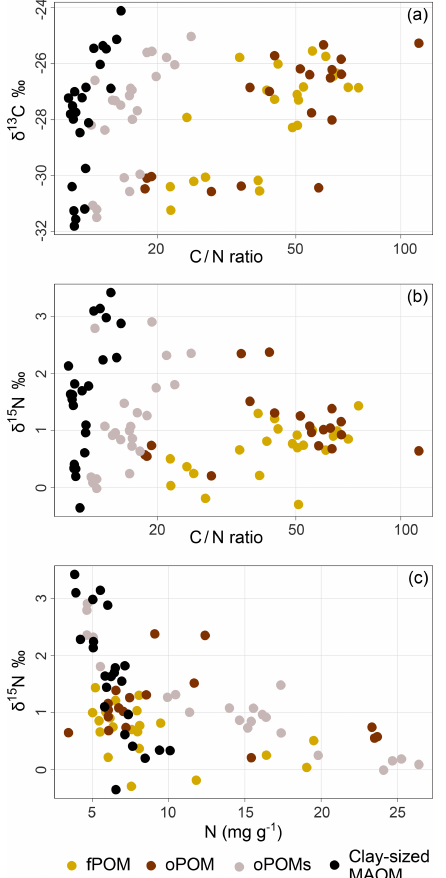
Figure 5. Principal component analysis (PCA) of δ 13 C (‰ relative to V-PDB), δ 15 N (‰ relative to air N 2 ), C and N content of the SOM fractions (free particulate OM – fPOM, occluded particulate OM – oPOM, small occluded particulate OM – oPOMs – and clay- sized mineral-associated OM – MAOM), C / N ratio of fractions and of bulk soils, and 13 C CP-MAS NMR-derived decomposition prox- ies (a / o-a ratio and 70–75 / 52–57 ratio). Dim: dimension. 75 / 52–57 ratio (Bonanomi et al., 2013) to the SOM